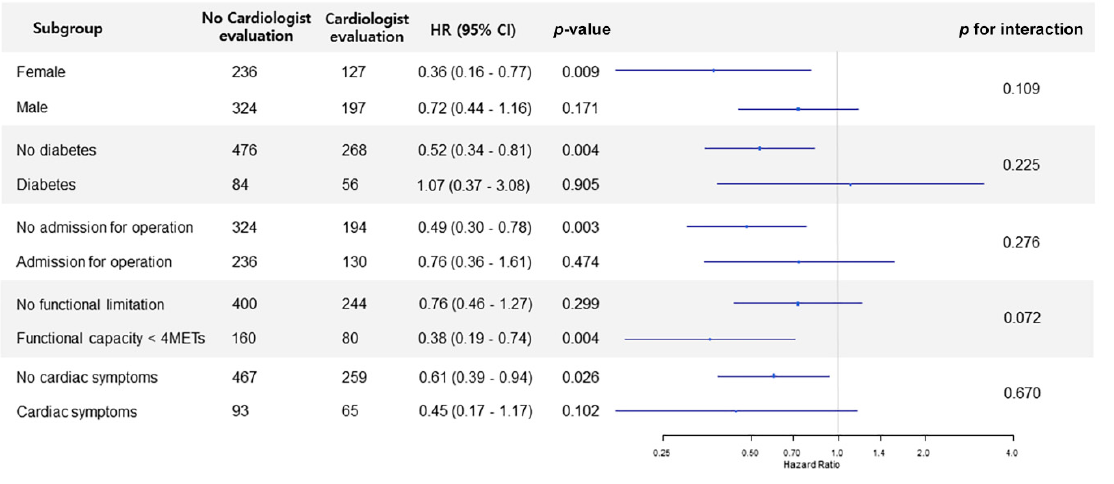
Figure 1. Kaplan–Meier curves of all-cause mortality in the ( A ) 30-day and ( B ) one-year mortalities for the entire population; and ( C ) 30-day and ( D ) one-year mortalities for the propensity-score matched population.